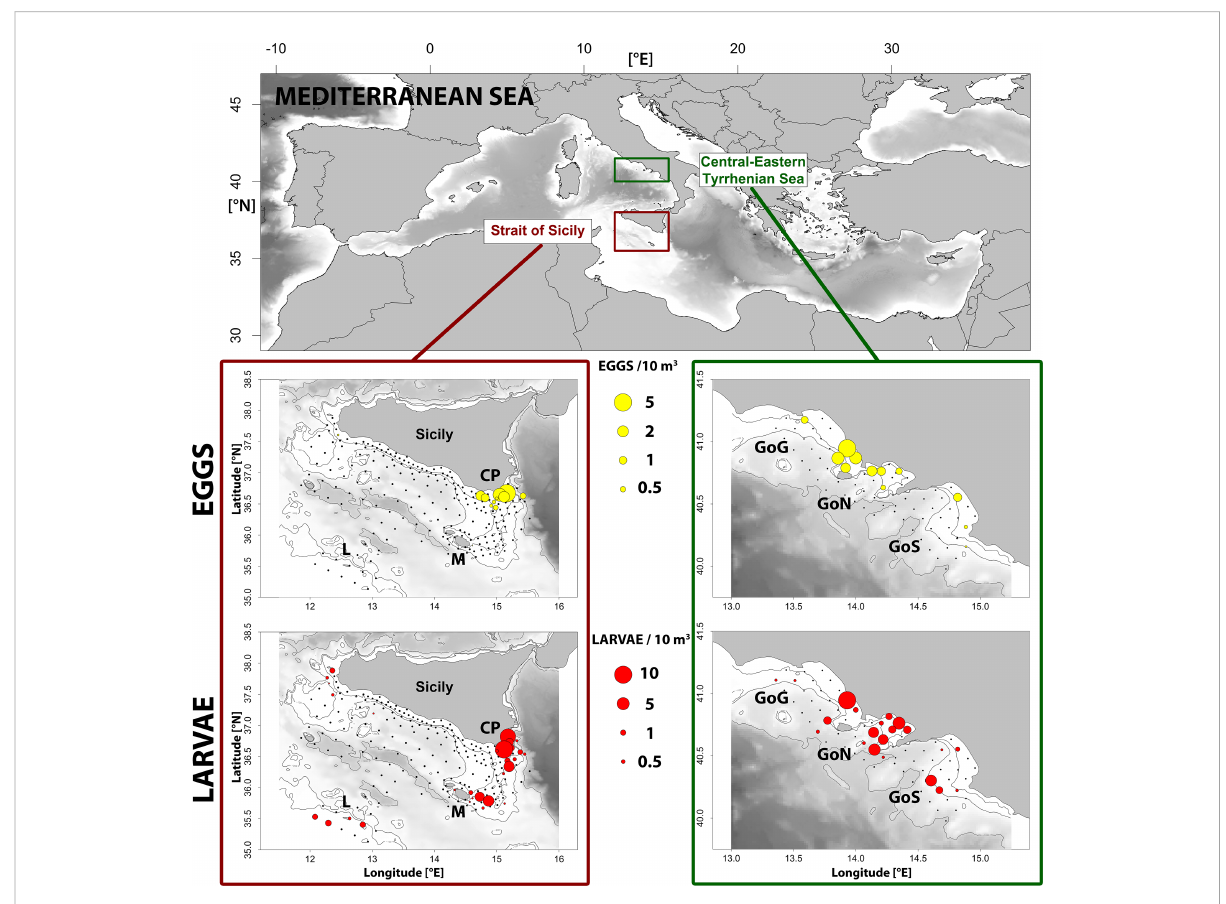
FIGURE 1 Spatial distribution of eggs and larvae of S. aurita in the Strait of Sicliy (left) and Central-Eastern Tyrrhenian Sea (right). In Strait of Sicily: CP, Capo Passero; M, Malta; L, Lampedusa. In Central-Eastern Tyrrhenian Sea: GoG, Gulf of Gaeta; GoN, Gulf of Naples; GoS, Gulf of Salerno. The isobaths of 100 m, 200 m and 1000 m have been reported in each